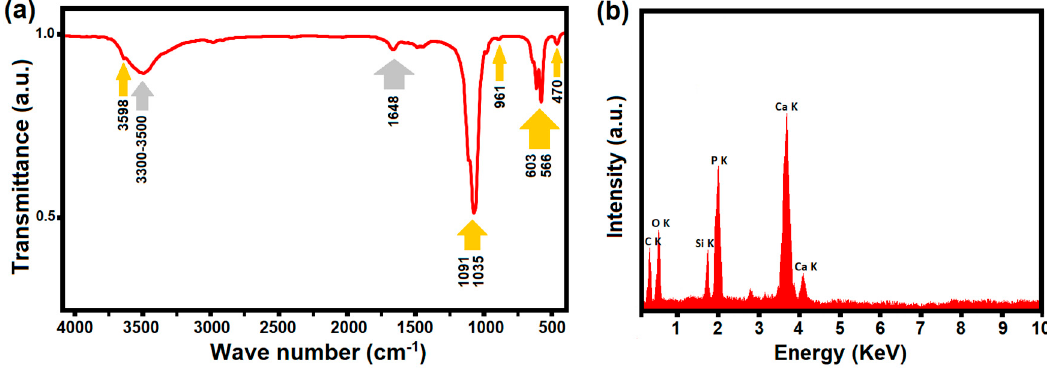
Figure 6. FTIR spectrum ( a ) and EDS analysis ( b ) of the as-prepared Sr-doped HA via the IL-assisted hydrothermal approach.